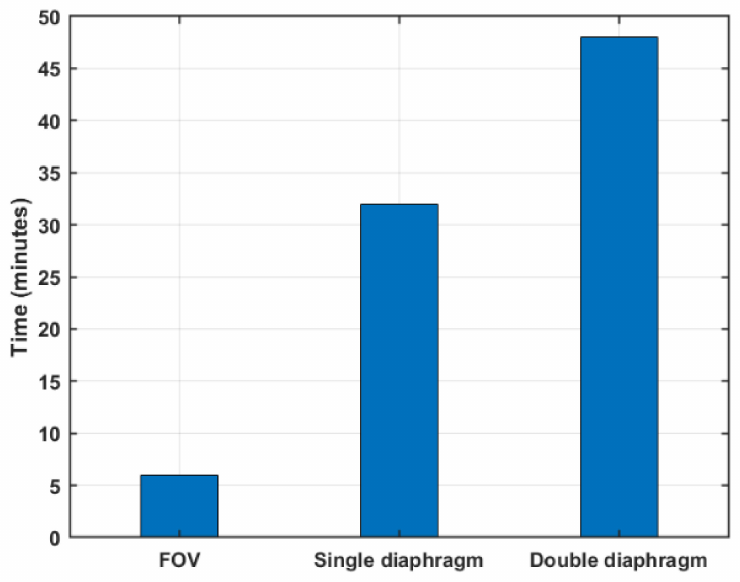
Figure 9. A comparison of the operation time of the three operating